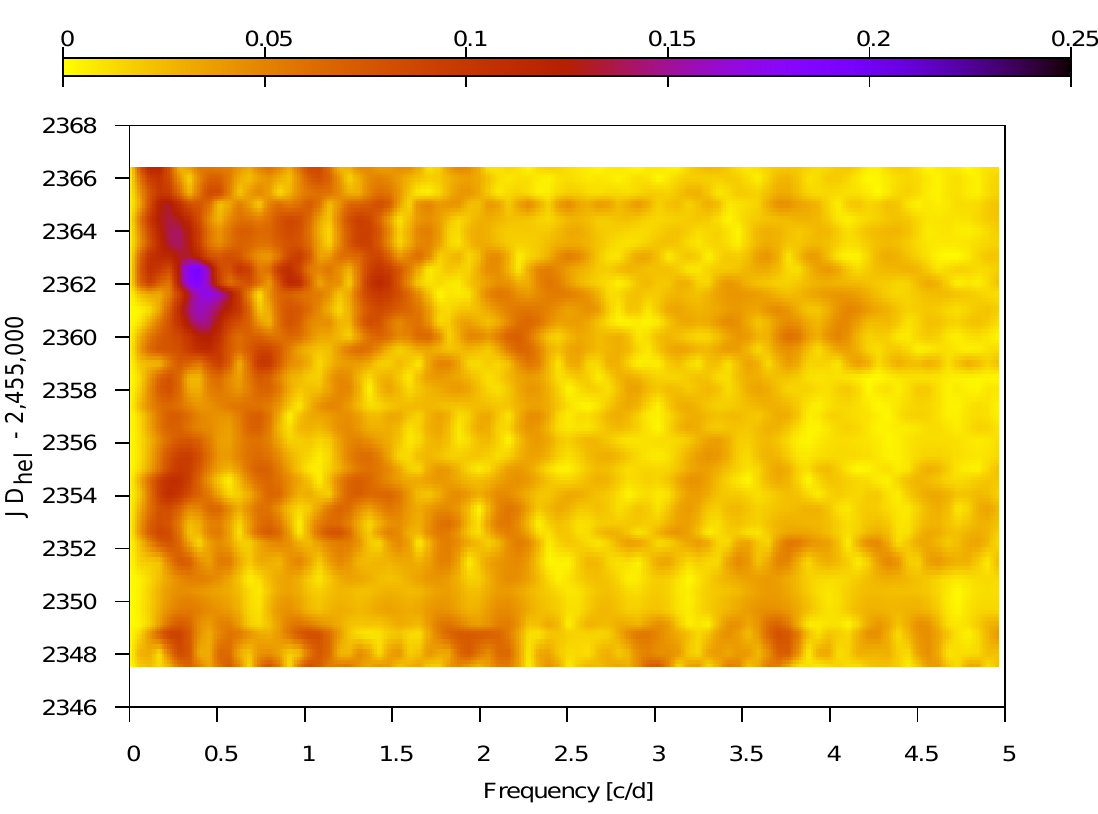
Figure 2. Running Fourier transform Running Fourier transform (rFT) of the OJ287 data gathered during the 2015/2016